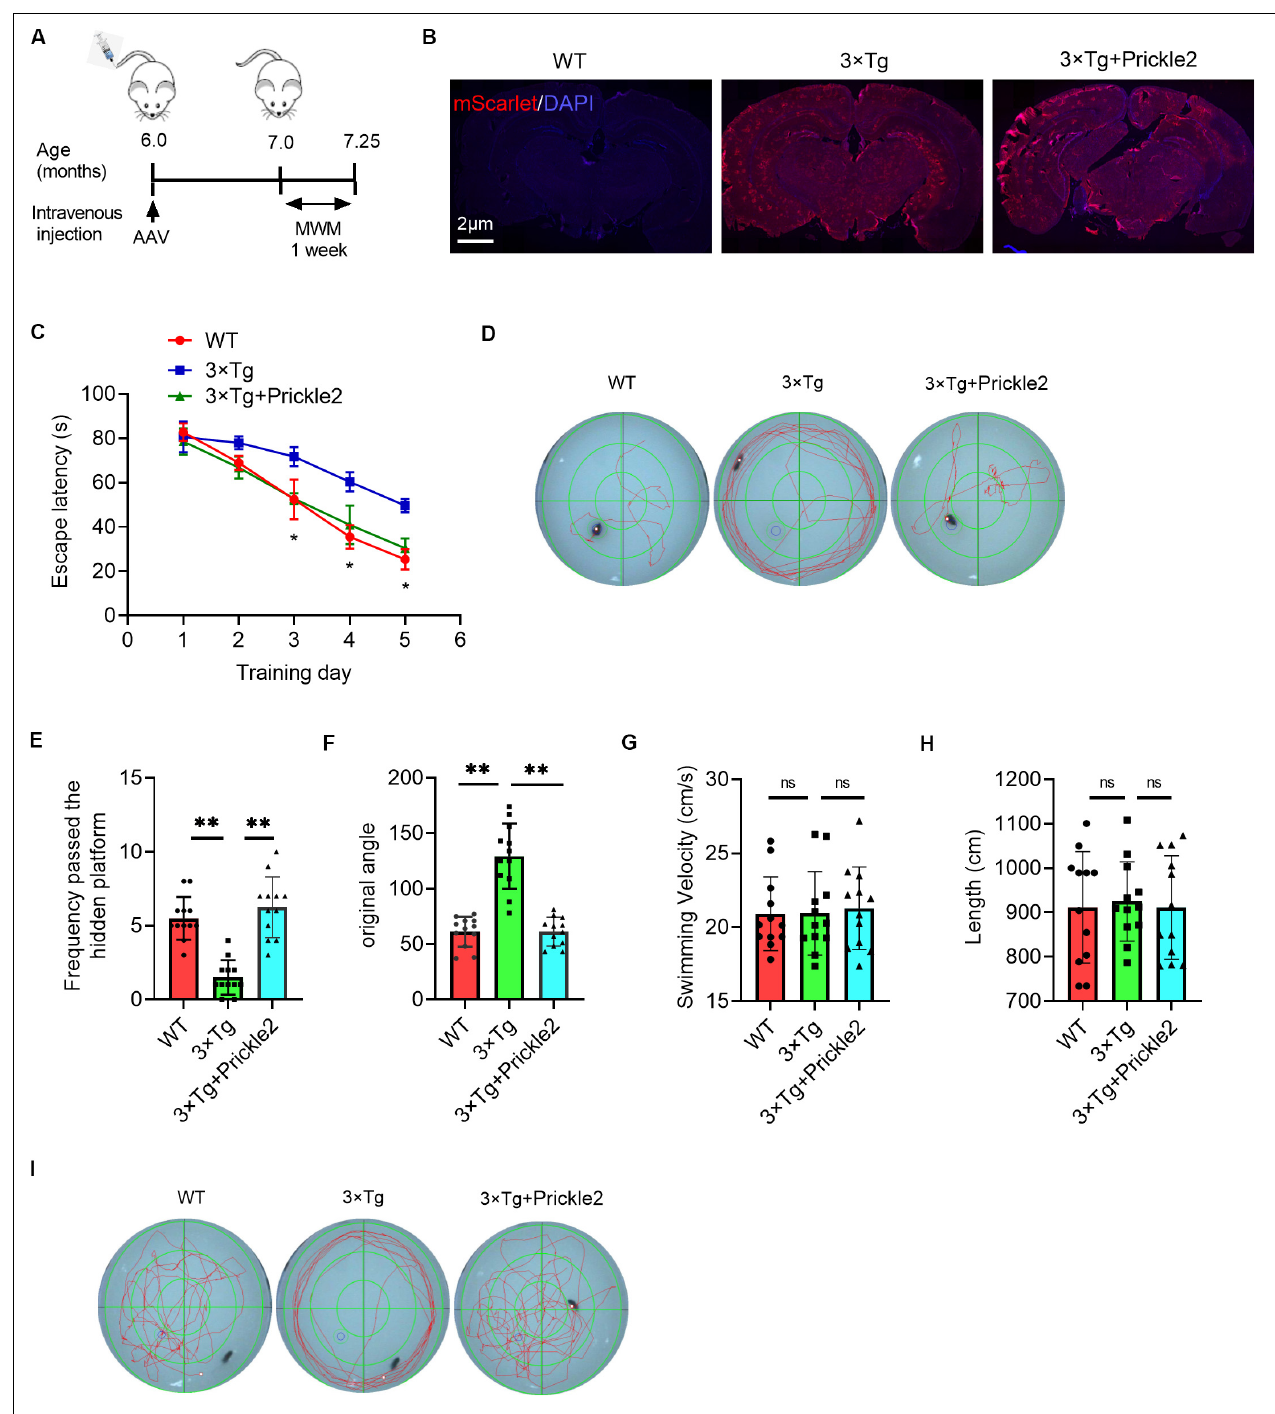
FIGURE 2 | AAV-mediated Prickle2 overexpression ameliorates impaired learning and memory in 3 × Tg mice. (A) Experimental schedule for AAV-PHP.eB-mediated Prickle2 treatment. (B) Evaluation of the infection efficiency after injection of AAV-PHP.eB virus. Immunofluorescence analysis showing the expression of mScarlet in the brain coronal sections. (C) Escape latency plotted according to the training days. (D) Typical swimming traces during the escape latency process through MWM test on day 5. (E) Frequency passed the hidden platform and (F) original angle data plotted during the MWM test on day 6. (G) The swim velocity and length (H) was calculated, and there was no significant group difference in average swim velocity or length. (I) Typical spatial probe process during the MWM test on day 6. All experiments were performed on 7-month-old mice ( n = 12). ANOVA followed by Bonferroni’s post hoc test. ∗ p < 0.05; ∗∗ p < 0.01; ns, not significant.